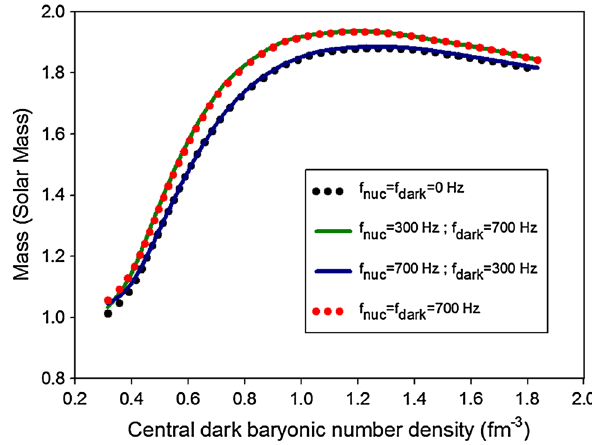
Fig. 6 Plots of total mass vs. central baryonic density of static, rigidly rotating and differentially rotating neutron stars mixed with self- interacting fermionic asymmetric dark matter with fixed dark matter central enthalpy (0 . 24 c 2 ) and varying nuclear matter central enthalpies